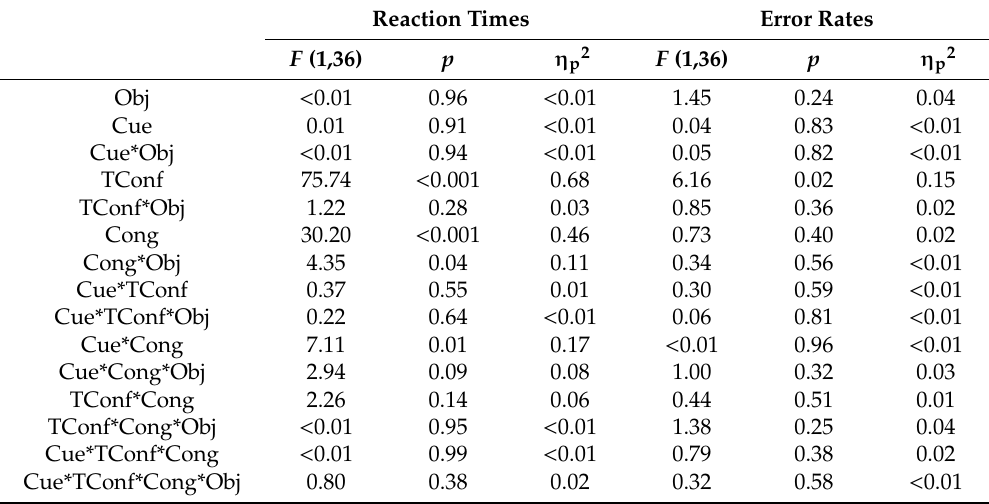
Table A1. Results of ANOVAs on the reaction times and error rates in Experiment 1 as a function of object, cue type, target configuration, and cue-target congruency.